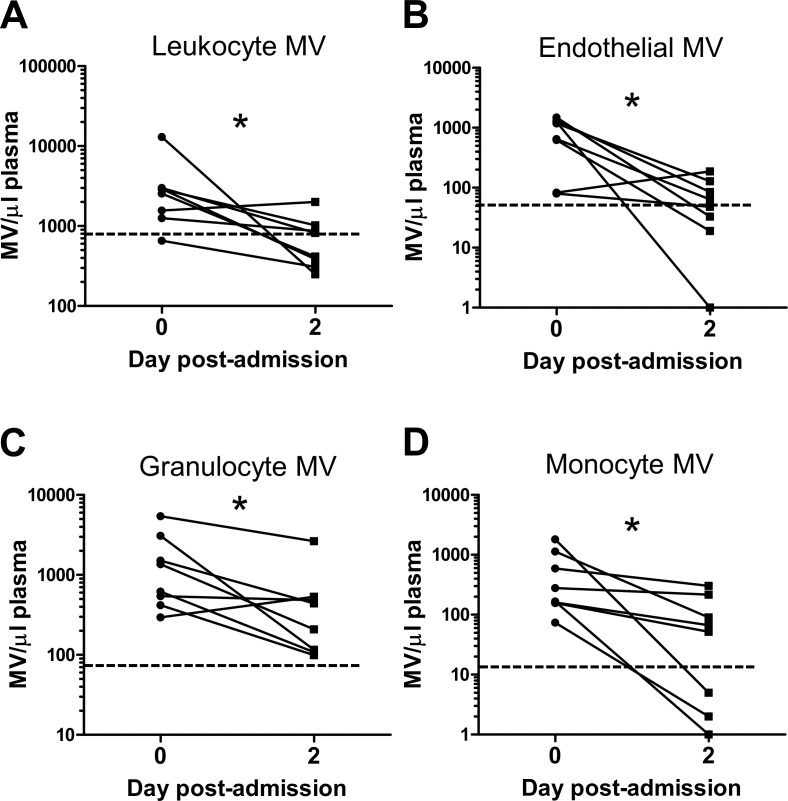
Comparison of circulating MV levels in burns patients on day 0 and day 2.Plasma from burns patients on admission day 0 and post-admission day 2 was analyzed by flow cytometry to quantify MVs of different cellular origin: CD45+ leukocyte-derived (A), CD105+ endothelia-derived (B), CD66b+/CD11b+ granulocyte-derived (C), and CD45+/CD14+ monocyte-derived (D). Data from individual patients are log-transformed and analyzed by paired t test (A, C and D) or Wilcoxon signed rank test (B). *p < 0.05.